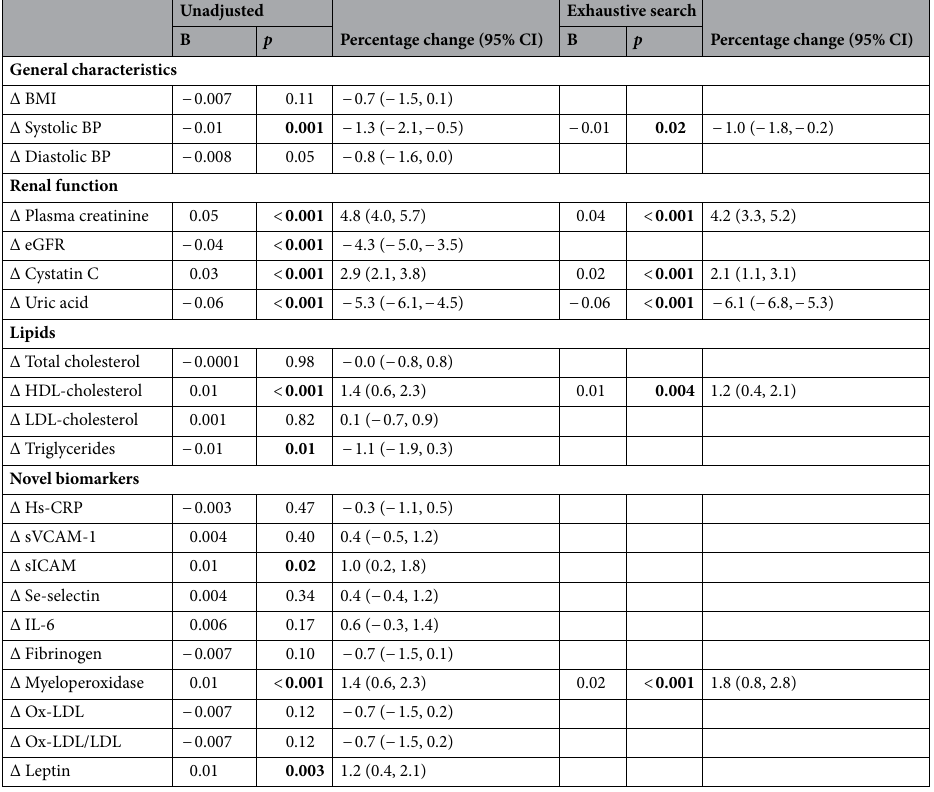
Table 3. Relationship change in baseline variables between V1 and V4 (16 weeks apart and at the end of 6 weeks of fenofibrate) (standardised*) and change in LMW-F between V1 and V4 (log-transformed). p values < 0.05 are bolded *Continuous variables have been standardised such that results relate to a 1 SD